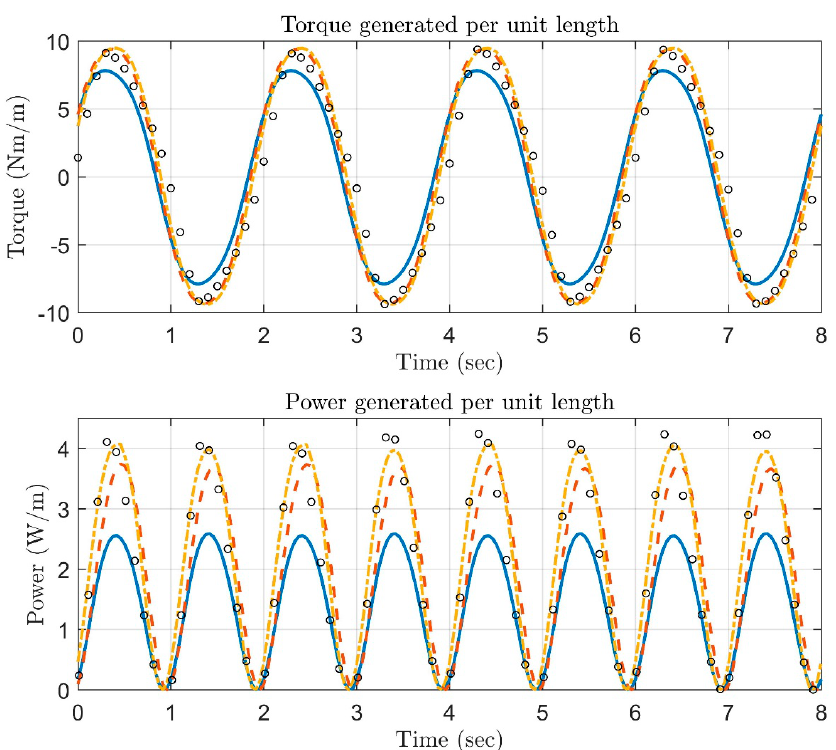
Figure 5. Torque output and power output timeseries between the present method and the experiments of [20] for f ∗ = 0.1, θ 0 = 50 o and V bg = 0.5 m / s . Crosses denote the experimental data, solid lines denote the results of the present method with AR = 3.4, dashed lines denote the results for AR = 10, and dash-dot lines are the results for AR = 20 .